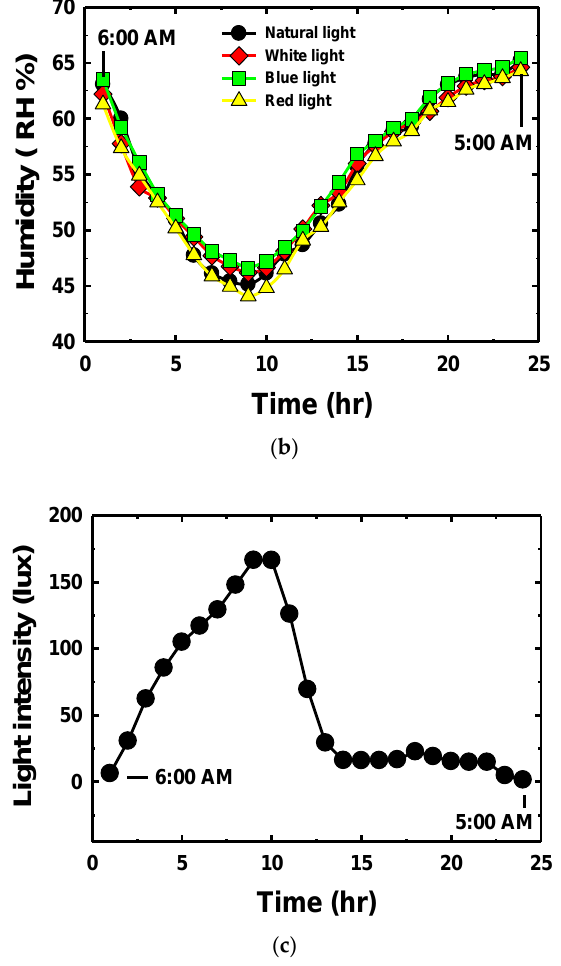
Figure 8. Environmental factors ( a ) temperature; ( b ) humidity; ( c ) light intensity. Table 2. Temperature, humidity, and luminosity in the day and nighttime. Time Temperature (°C) Humidity (RH %) Light Intensity